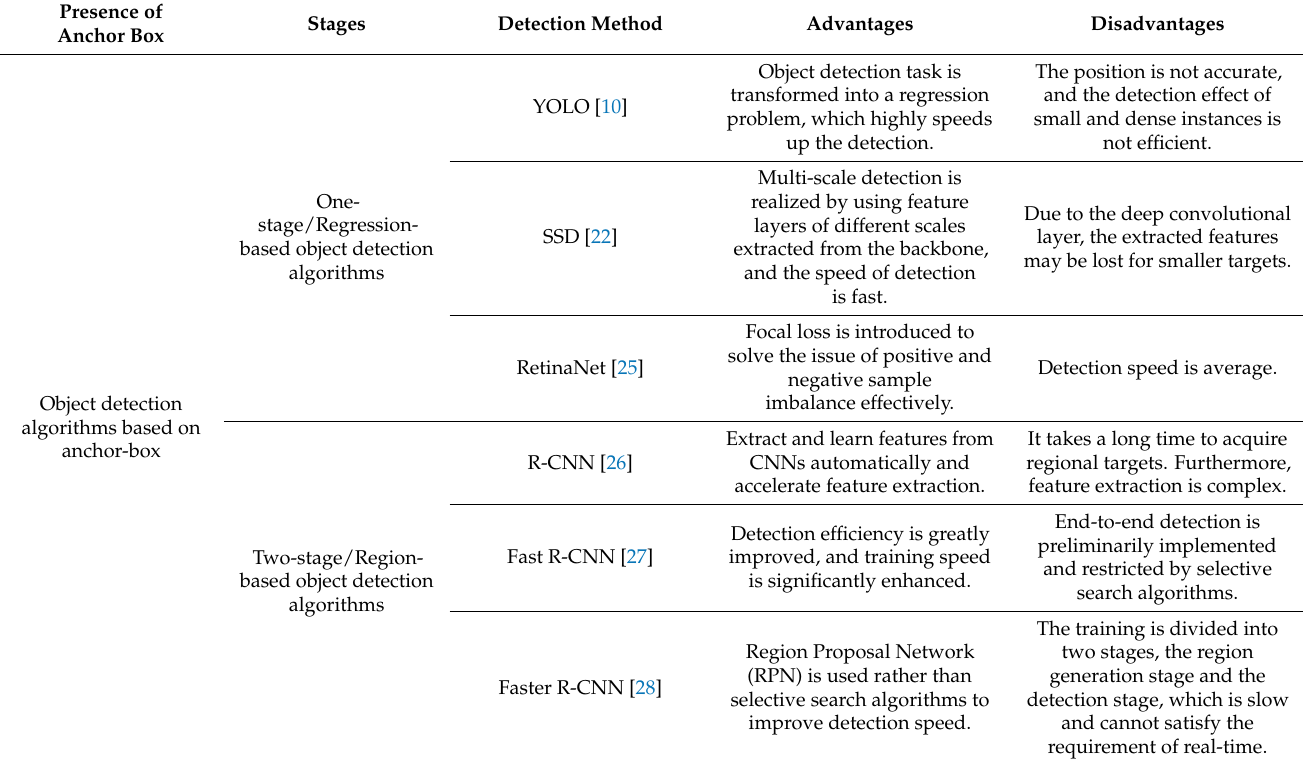
Figure 3. Overall network structure.